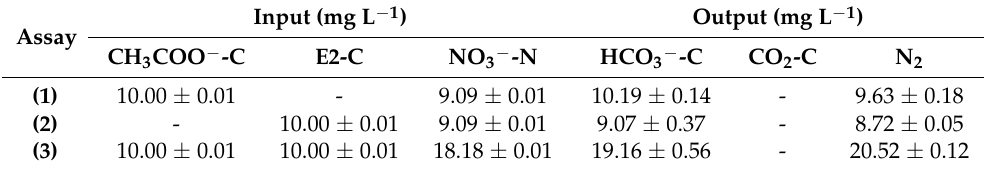
Table 3. Mass balance of denitrifying assays.